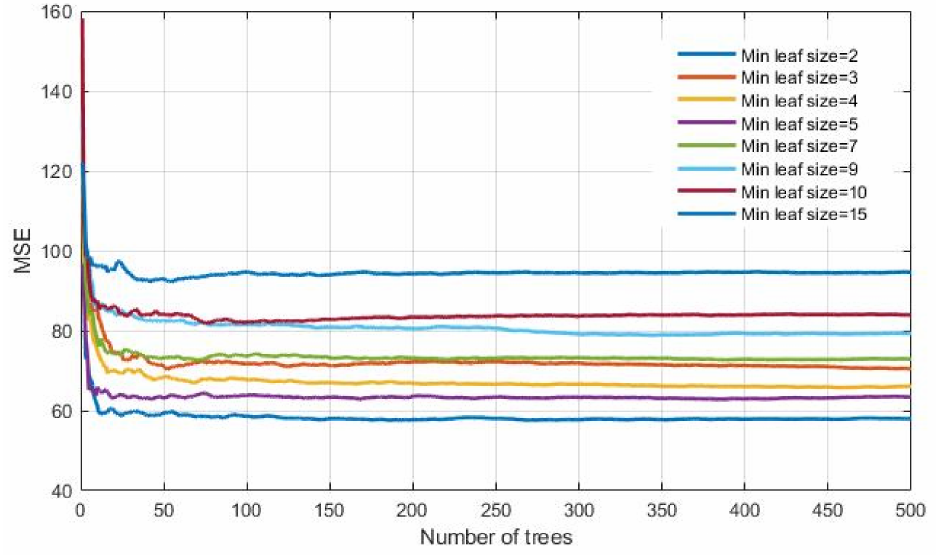
Figure 12. MSE vs. number of trees in the ensemble for different minimum leaf sizes using regression tree ensembles realized with bootstrap aggregation